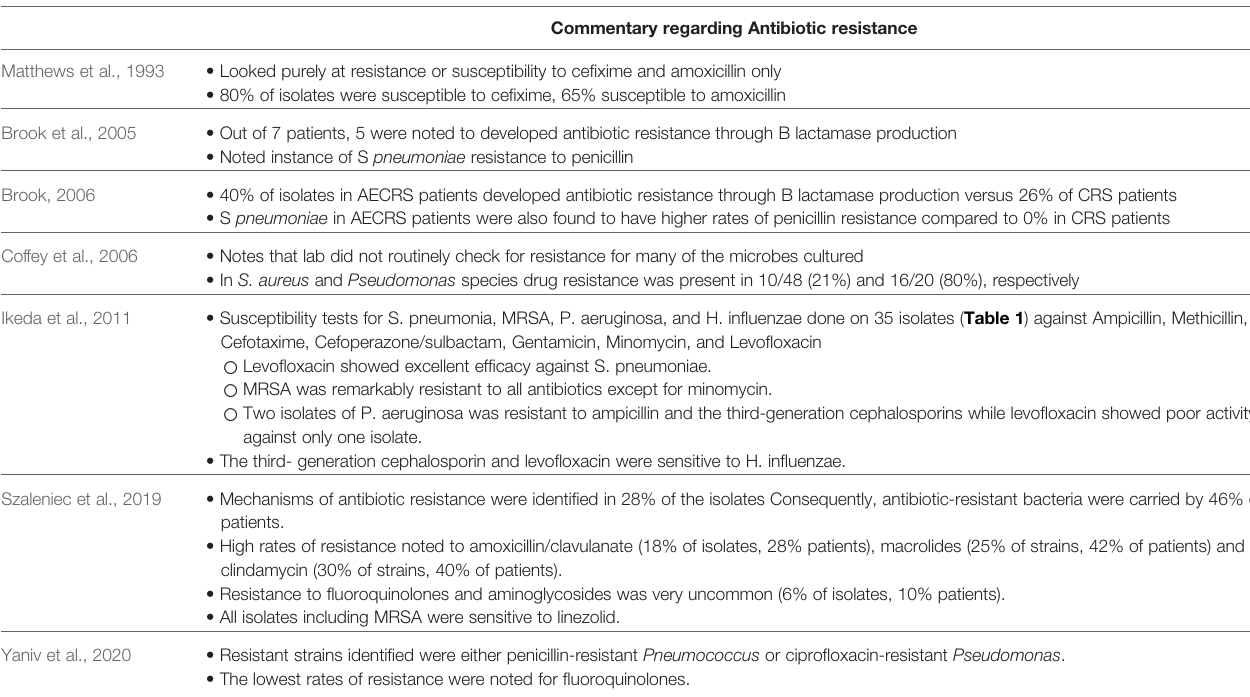
TABLE 3 | Key points mentioned regarding antibiotic resistance in key studies.